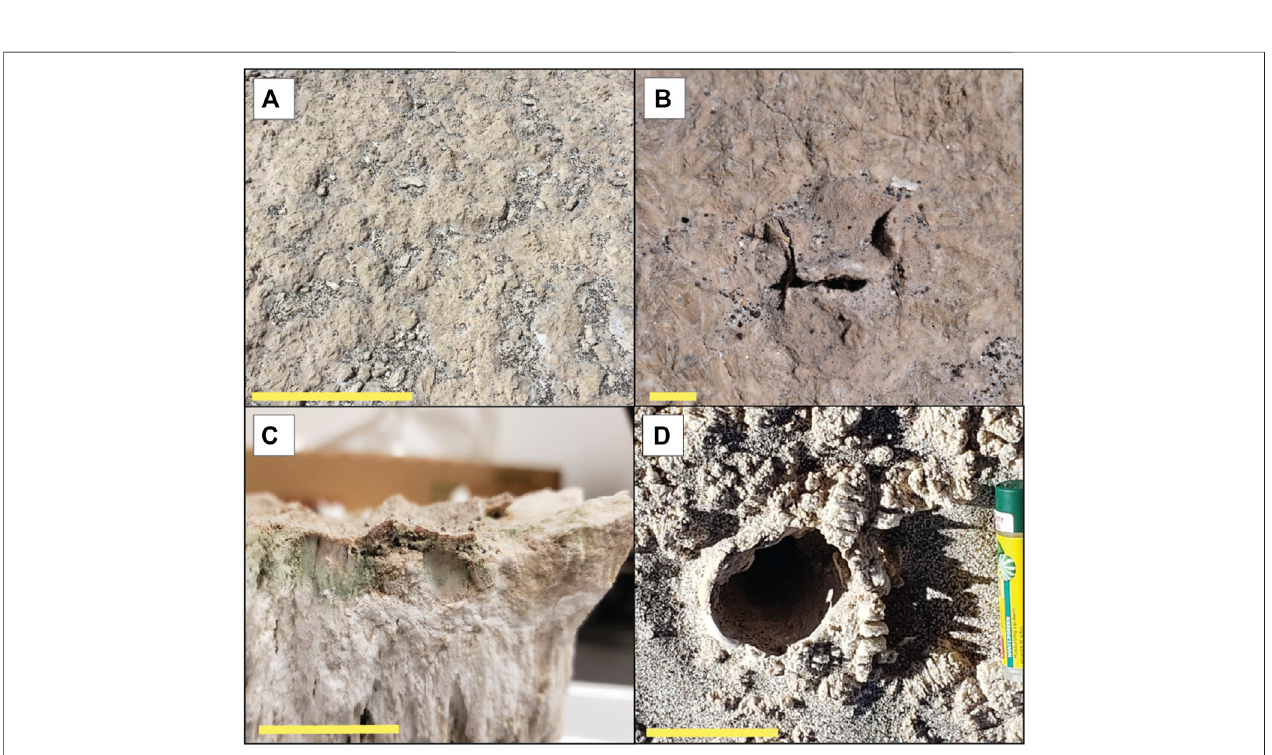
FIGURE 5 | Surface textures and holes. (A) View of rugosic texture and regolith from above. Scale bar is ca. 50 cm. (B) Partially detached duricrust on smooth surface. Scale bar is 1 cm. (C) Partially detached duricrust. Note pigments below duricrust. Scale bar is 1 cm. (D) Lined hole in bulbous texture with regolith. Scale bar is 5